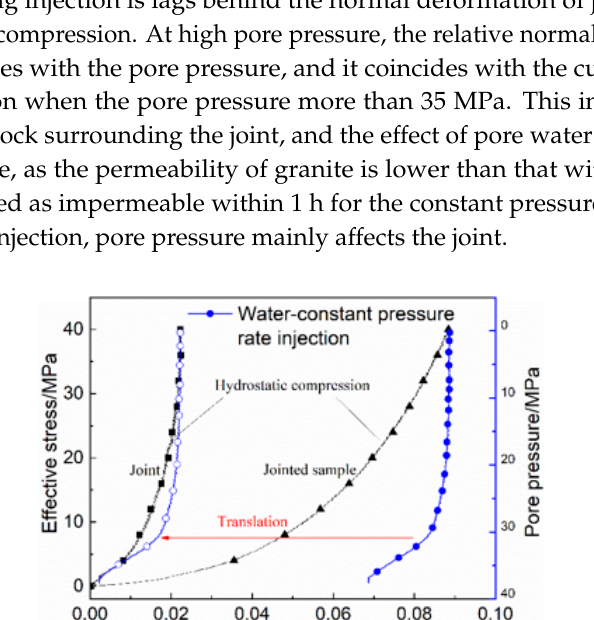
Figure 8. The relative normal deformation of jointed sample during the water injected in constant pressure rate injection.